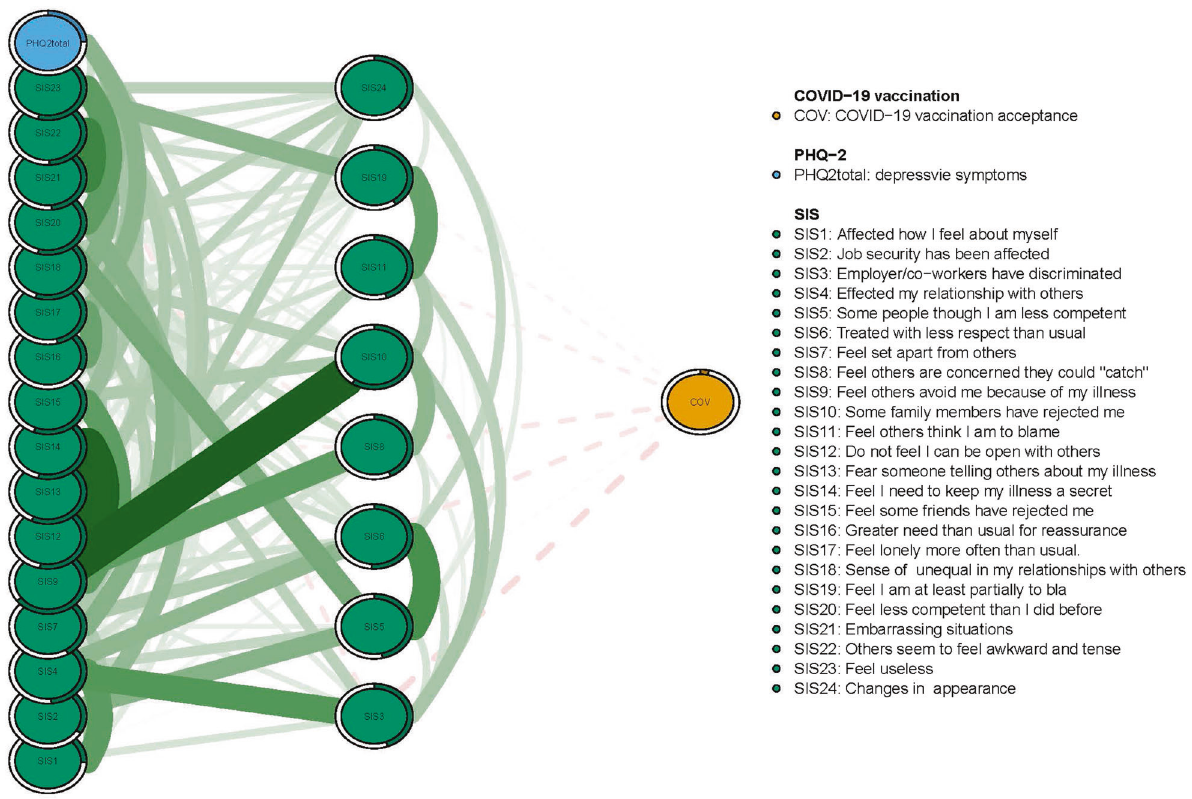
Fig. 3 Flow network of future COVID-19 vaccine acceptance. Ring-shaped pie charts represent predictability (a fully fi lled dark ring would indicate that 100% of the symptom ’ s variance is explained by its inter correlations with the other symptoms in the network). In the diagram symptom nodes with stronger connections are closer to each other. The blue node denotes the PHQ-2 total score items (2-items Patients Health Questionnaire); the red node denotes the SIS items (Social Impact Scale). The dark green lines represent positive correlations. The red lines represent negative correlations. The edge thickness represents the strength of the association between symptom